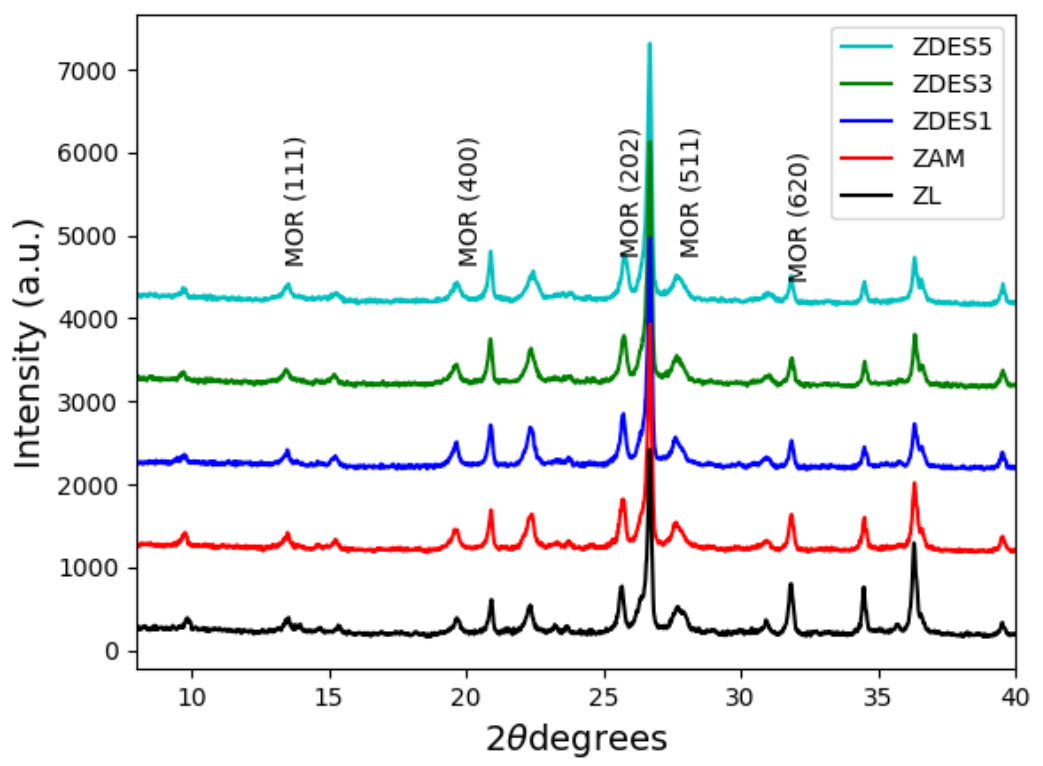
Figure 2. XRD patterns of the raw material (ZL); ammonia-exchanged sample (ZAM); and dealumi- nated samples (ZDES1, ZDES3, and ZDES5).